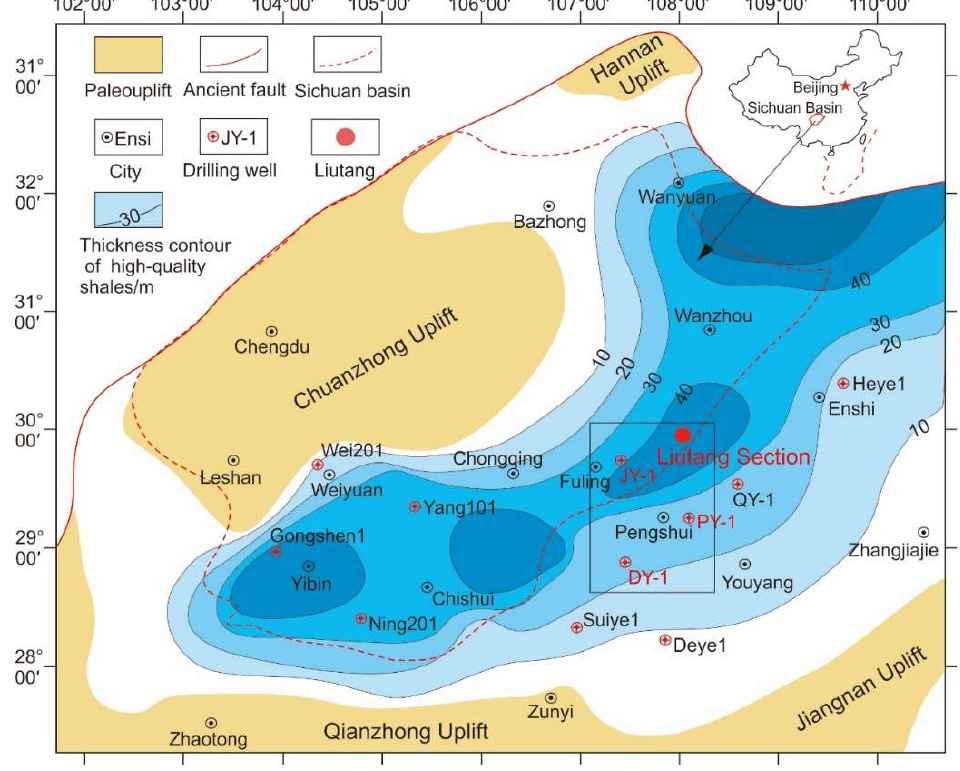
Figure 1. Paleogeographic map of Yangtze area during the late Ordovician and early Silurian periods, and the location of Liutang section.